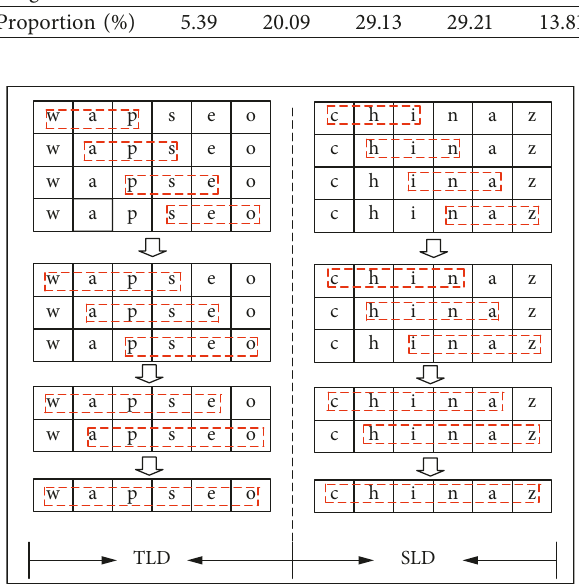
Figure 3: Process of domain name